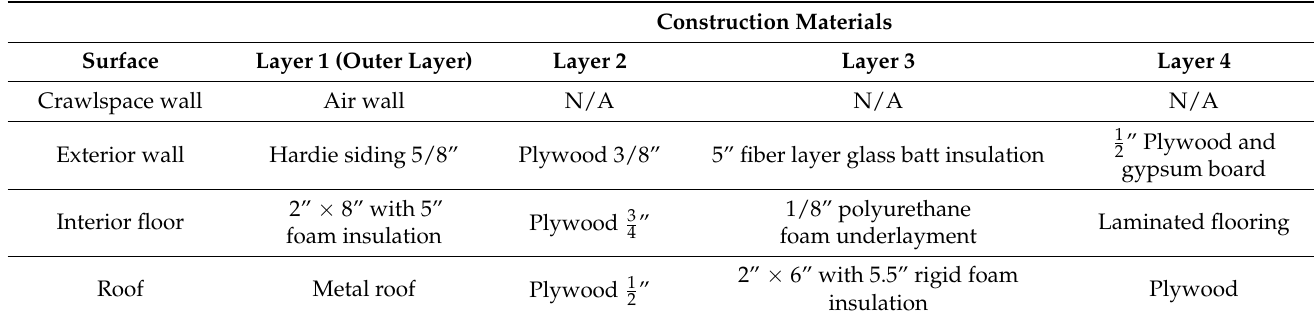
Table 5. Construction materials used for the model.